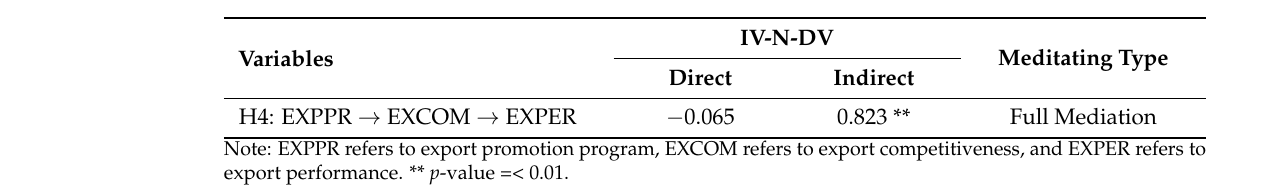
Table 4. Mediating Effect